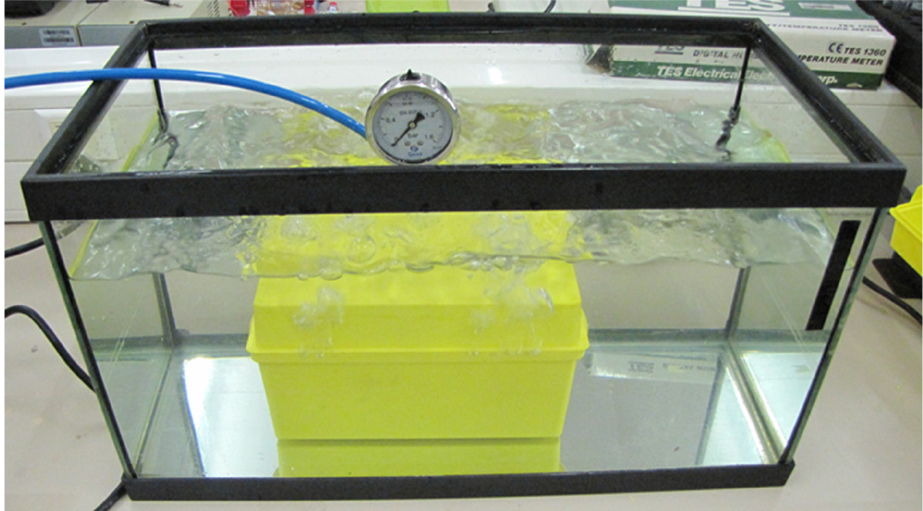
Figure 4. Testing the pressure tightness of a secondary container (package 5) immersed in water.